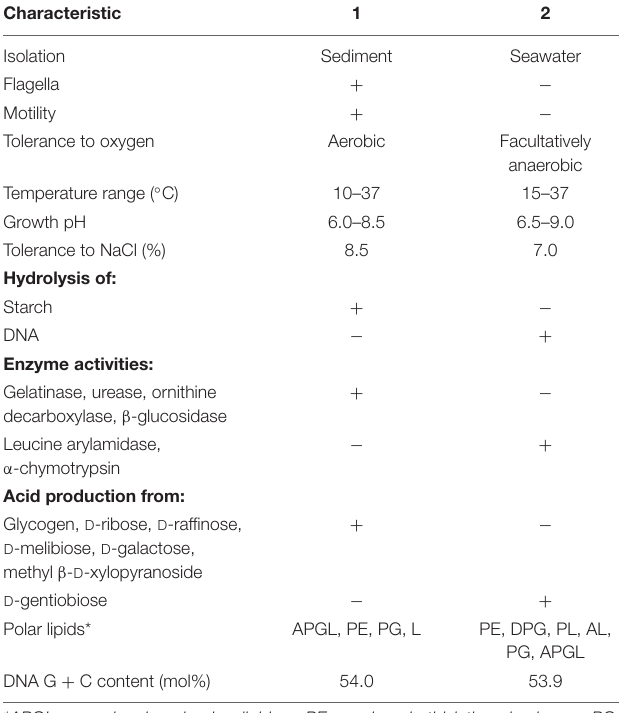
TABLE 4 | Characteristics that differentiate strain NFK12 T and related type